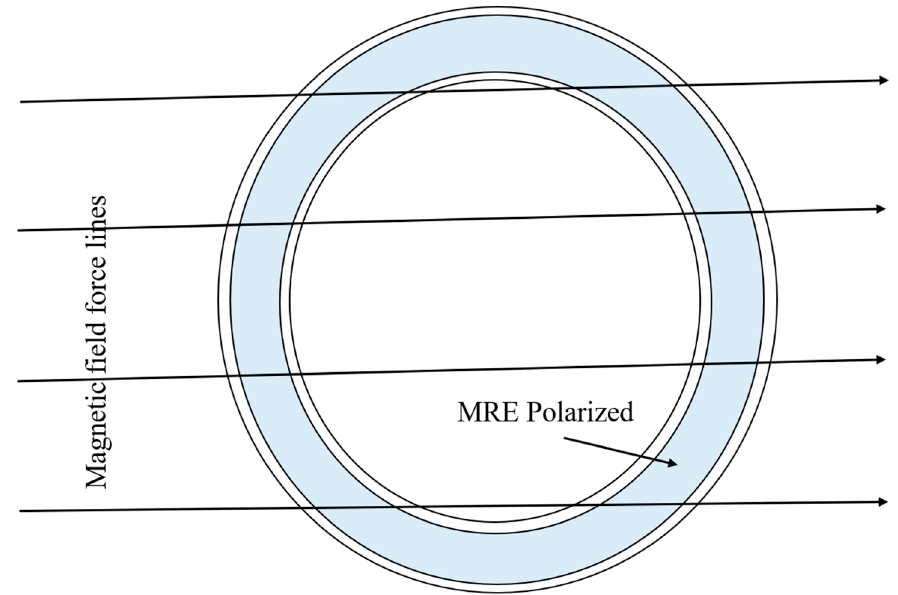
Figure 14. Three ‐ layered circular cylindrical shell with polarized MRE in the magnetic field. Figure 14. Three-layered circular cylindrical shell with polarized MRE in the magnetic